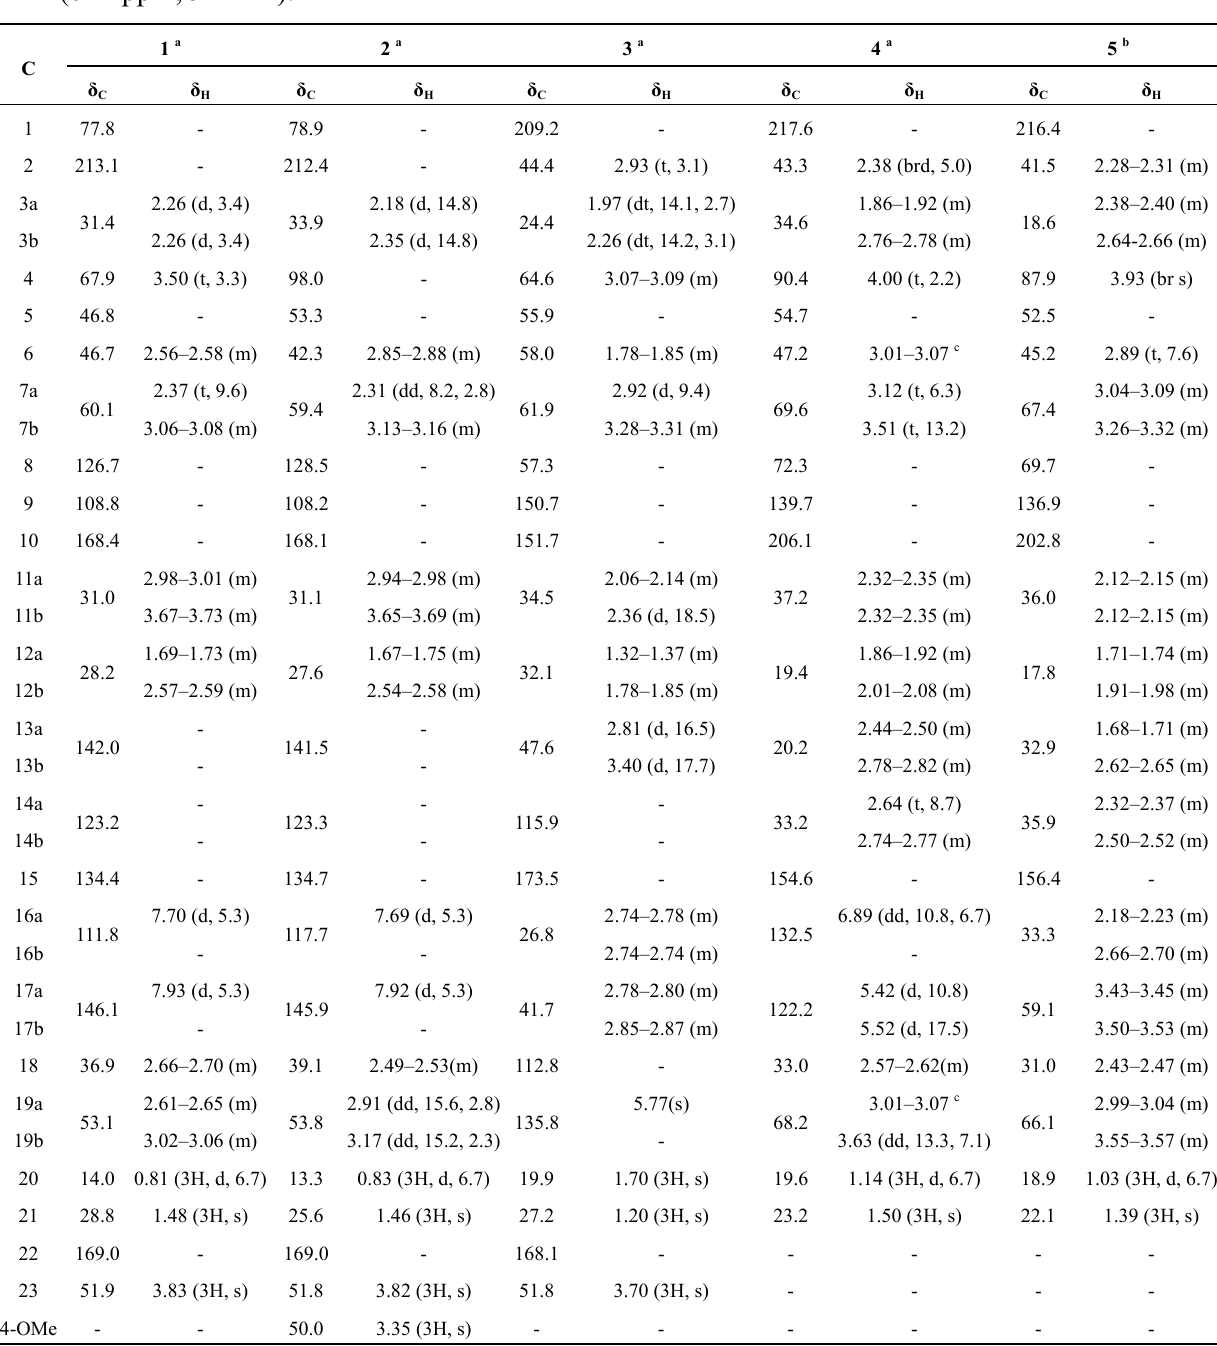
Table 1. 1 H-NMR (500 MHz) and 13 C-NMR (125 MHz) data for compounds 1 – 5 ( δ in ppm, J in